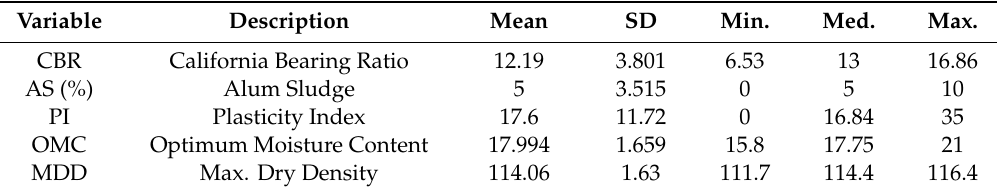
Table 4. Data description of properties of